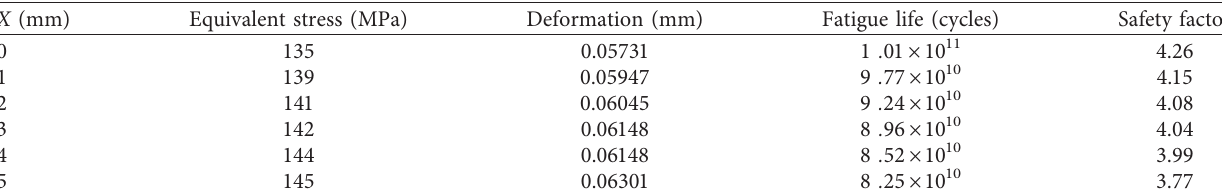
Figure 19: A graph of results for designs with different neck radii and without modeled crack. Table 2: Results obtained for chain link with a modeled